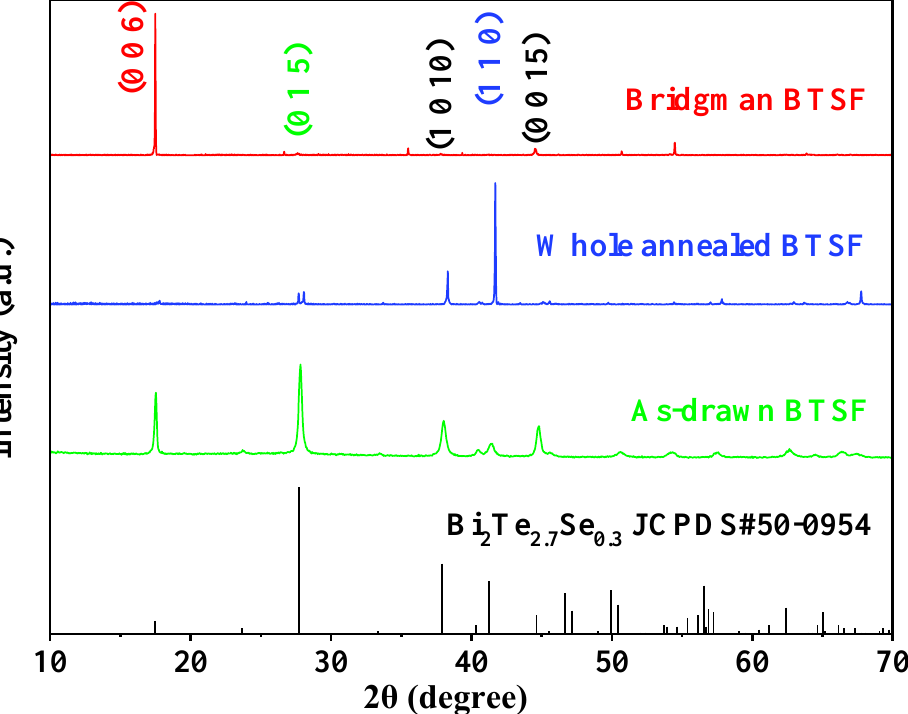
Figure 1. XRD patterns of the as-drawn and annealed BTSF.